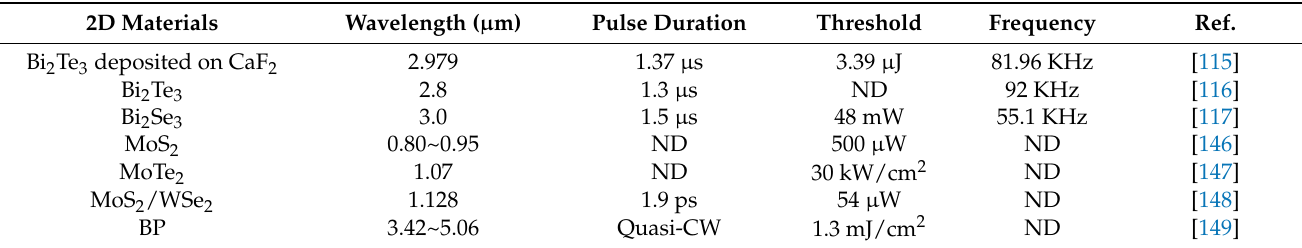
Table 3. Laser operation based on 2D